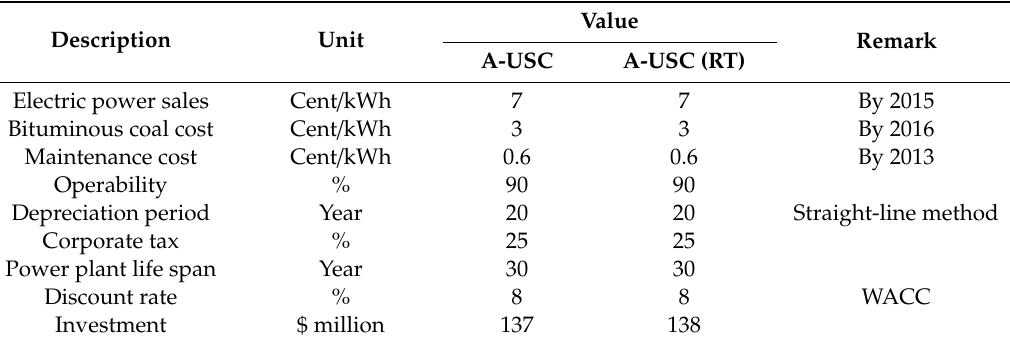
Table 5. Required data for economic analysis.